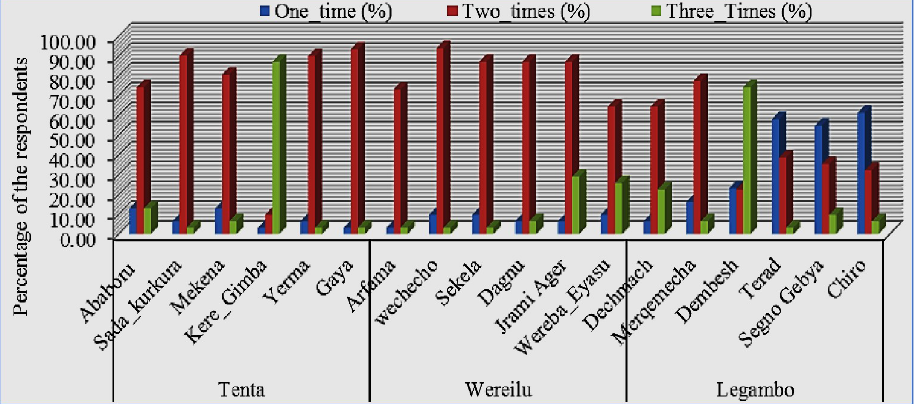
Fig 2. The ploughing frequency of the land before